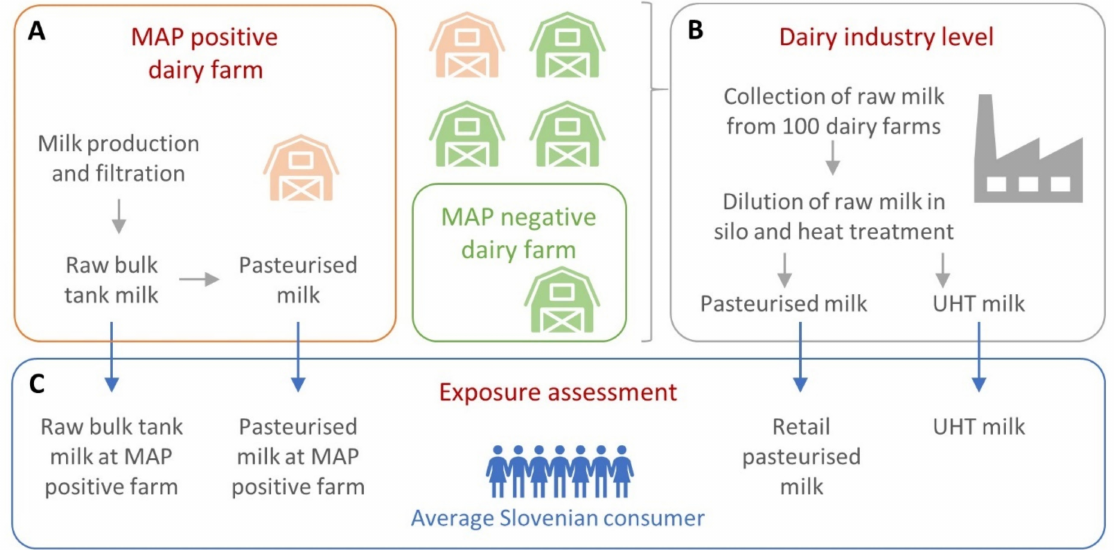
Figure 1. Schematic structure of the model for quantitative risk assessment of exposure to Mycobac- terium avium subsp. paratuberculosis (MAP) via different types of milk for the Slovenian consumer. The model consists of three parts: ( A ) a farm-level sub-model, ( B ) a dairy industry-level sub-model, and ( C ) a potential human exposure